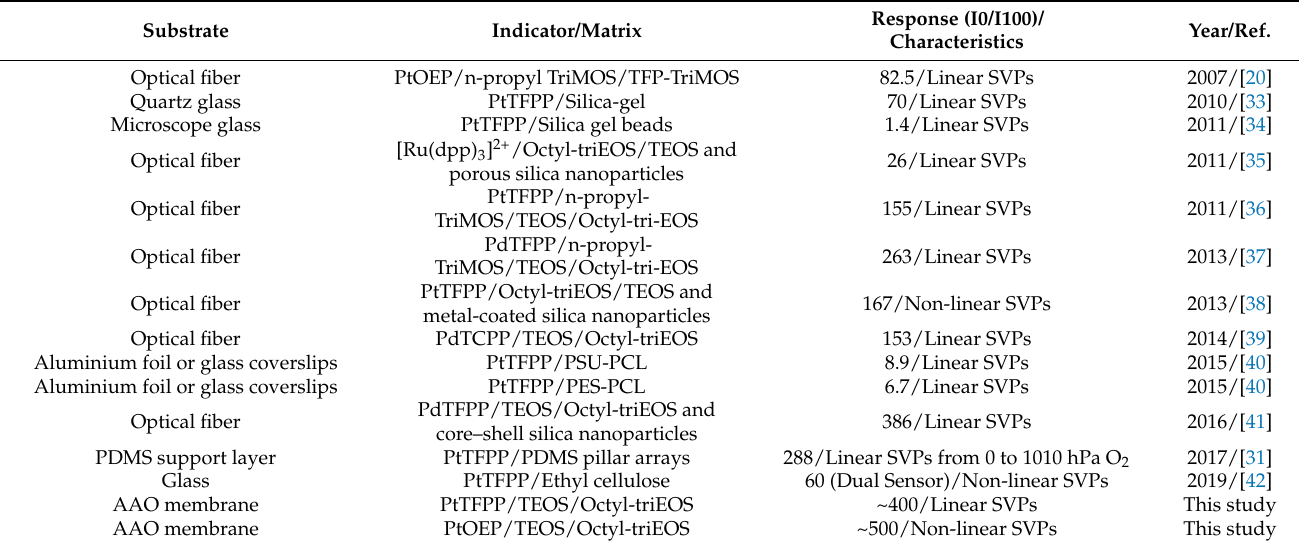
Table 1. Responses of various optical oxygen sensors are compared